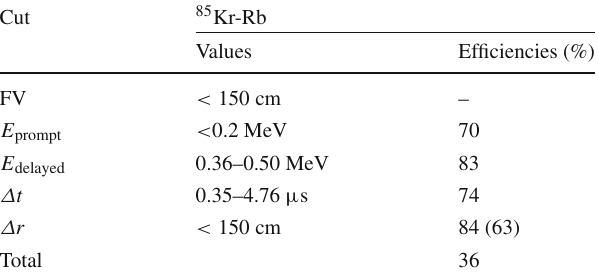
Table 9 Efficiencies of the different data selection cuts for the 85 Kr measurement. As in the Bi–Po selection, Δ t and Δ r are time and dis- tance cuts. For the latter, the numbers in brackets represent the rejection efficiency for accidental coincidences. The reduced efficiency for the prompt energy selection is caused by the instrumental trigger threshold of 5 hits in 70 ns